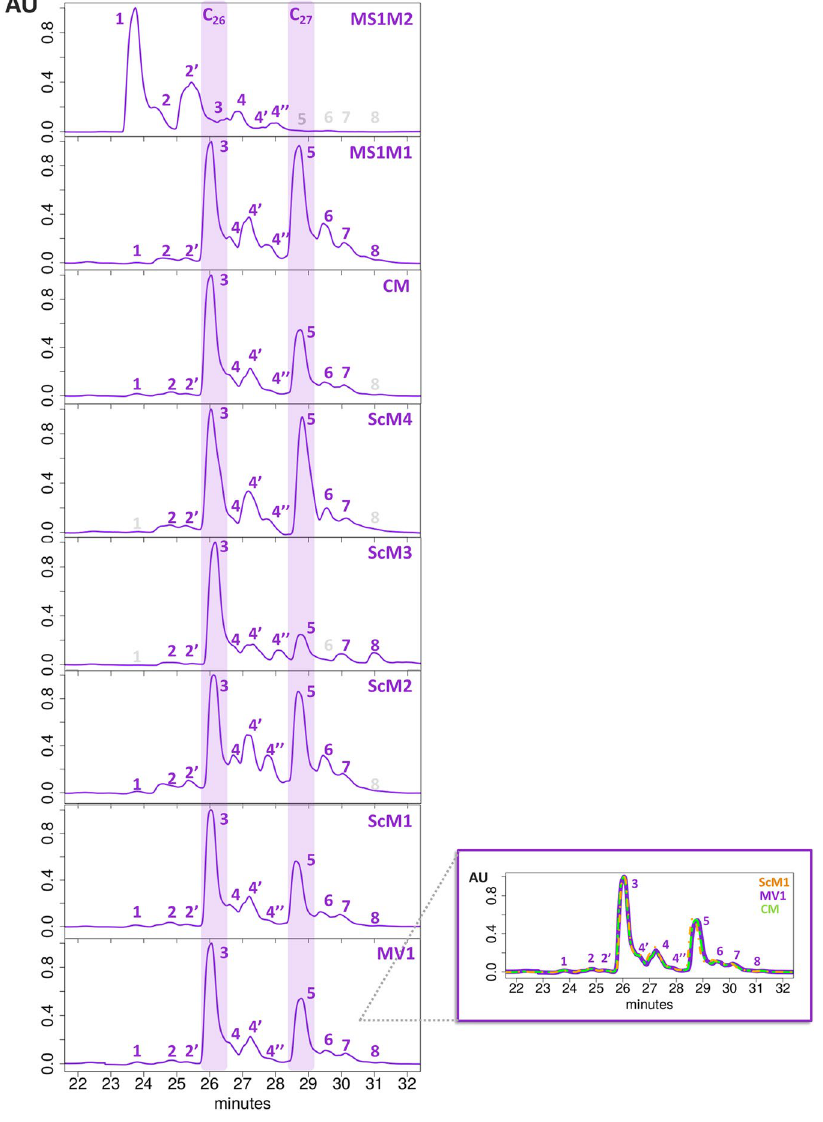
Figure 2. HPLC-DAD chromatograms of historical samples of mauveine salts at λ = 550 nm for Science Museum 1 (ScM1), Science Museum 2 (ScM2), Science Museum 3 (ScM3), Science Museum 4 (ScM4), Museum SI Manchester 1 (MS1M1), Museum SI Manchester 2 (MS1M2) and Chandler Museum (CM). All samples were dissolved in methanol. The major components identified are labelled as: 1–pseudo-mauveine (C 24 ); 2 and 2 ′ – two monomethylated C 25 isomers (C 25a and C 25b ); 3 – one dimethylated mauveine (C 26 ); 4, 4 ′ , 4 ″ and 5 – four trimethylated mauveines (including C 27 and B2, B3 and B4 isomers); 6 and 7 – two tretamethylated mauveines (C 28 C, C1 isomers); 8 – one pentamethylated mauveine (C 29 ). For details see refs. 2, 8. Purple labels refer to the mauveine structures identified in each sample; grey labels refer to unidentified compounds. In